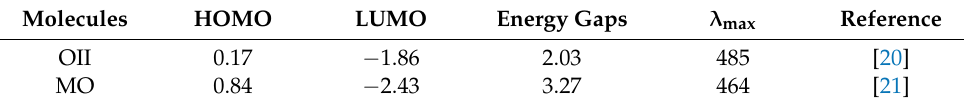
Table 3. HOMO and LUMO levels and energy gaps (eV) of dye molecules and λ max (nm). Molecules HOMO LUMO